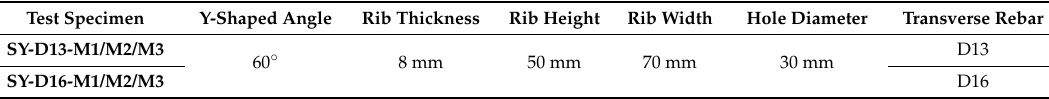
Table 3. Specifications of the stubby Y-type perfobond rib